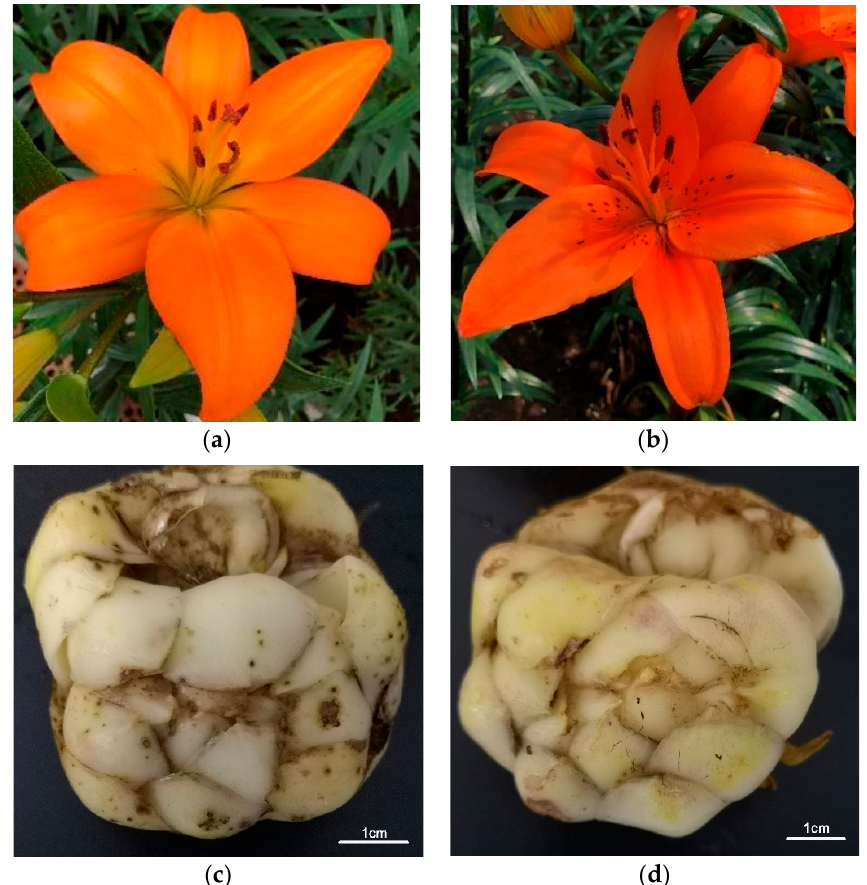
Figure 10. Pictures of functional lilies. ( a ) flower of ‘Fly Tiancheng’ ( b ) flower of ‘Fly Shaohua’ ( c ) bulb of ‘Fly Tiancheng’ ( d ) bulb of ‘Fly Shaohua’.